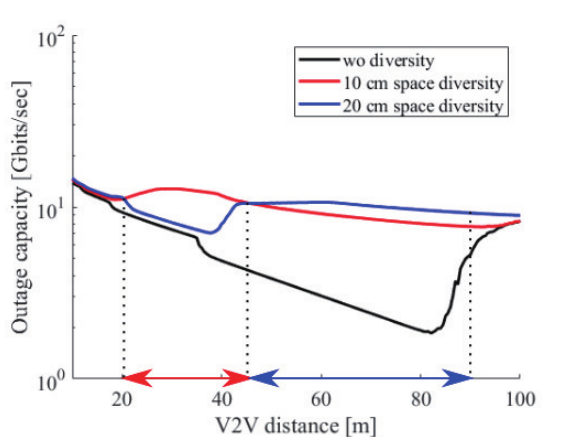
Figure 15. The 0.01% outage capacity with height diversity under h t1 , h r1 = 0.38 m, h r2 = 0.48 m, and h r2 = 0.58 m and without diversity at 60